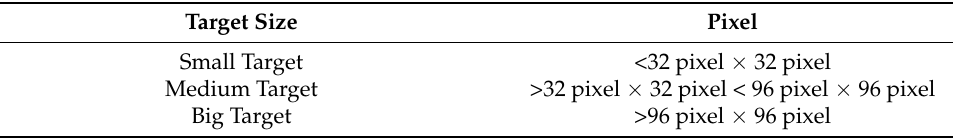
Table 1. Definition of small targets in the MSCOCO